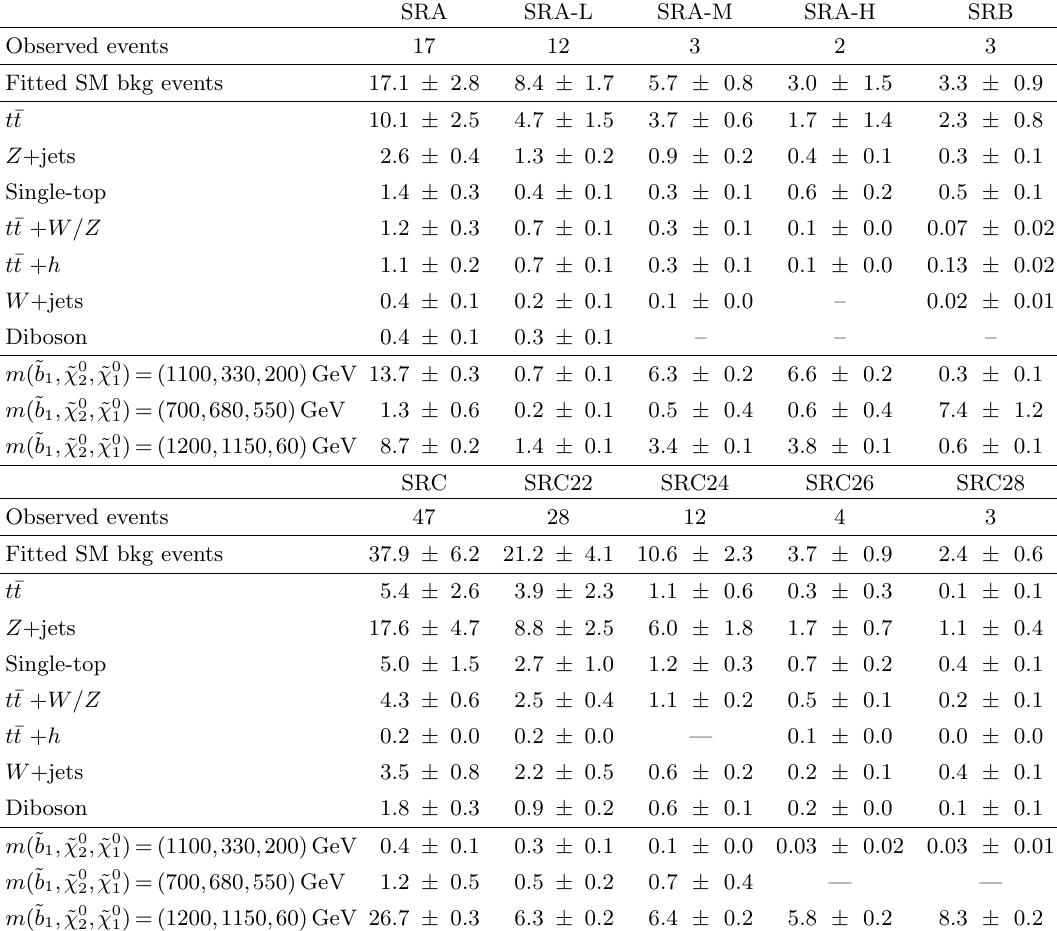
Table 6. Background-only (cid:12)t results for the A- and B-type regions (top table) and C-type re- gions (bottom table) performed using 139 fb (cid:0) 1 of data. The quoted uncertainties on the (cid:12)tted SM background include both the statistical and systematic uncertainties.